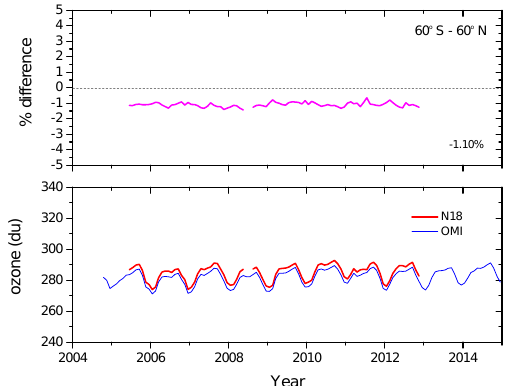
Figure 3. The ozone time series averaged from 60 ◦ S to 60 ◦ N for OMI and for the SBUV/2 on NOAA 18 are shown in the bottom plot. The percent difference in the upper plot shows that OMI ozone had very little trend relative to N18 but had an average bias of − 1.1%.